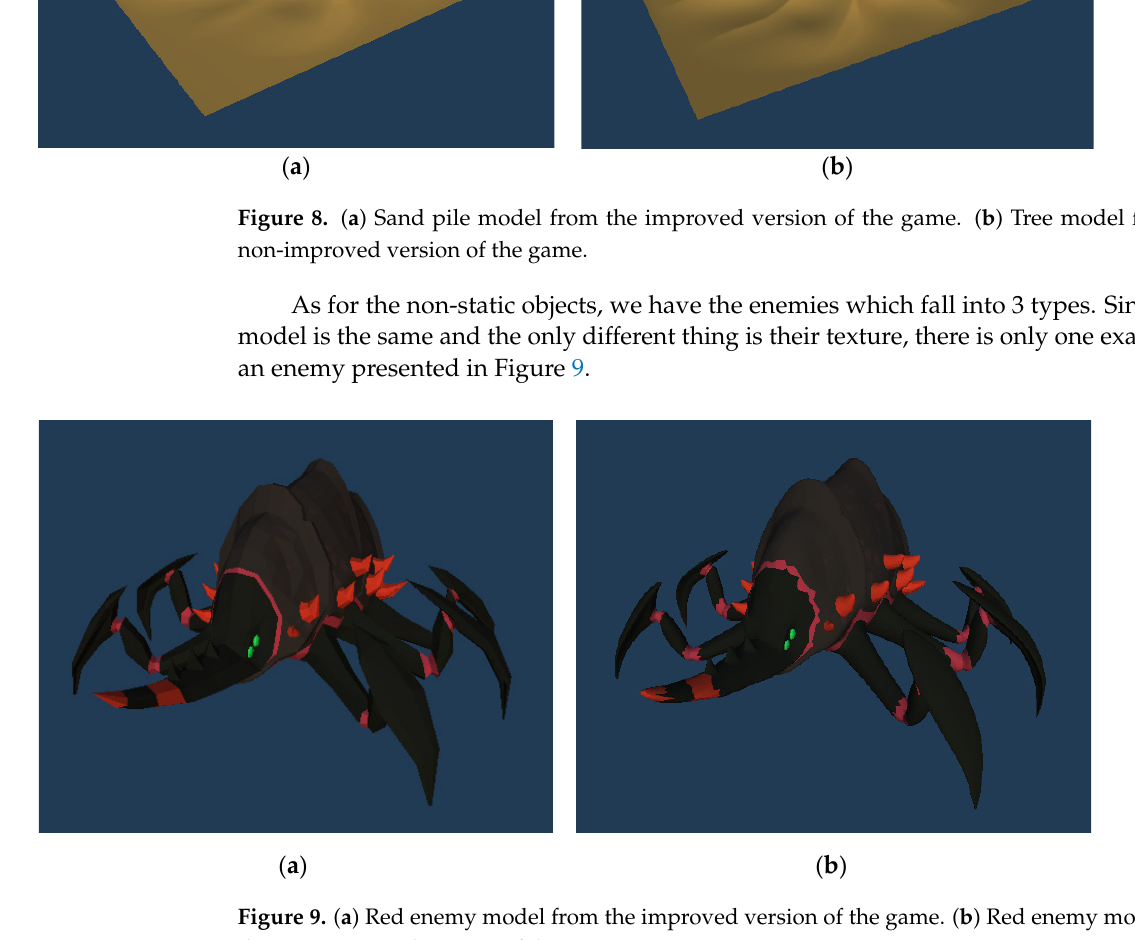
from the non-improved version of the game. the non-improved version of the